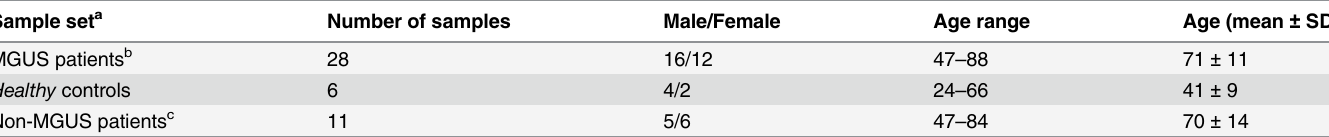
Table 1. Patient demographics and disease characteristics. Sample set